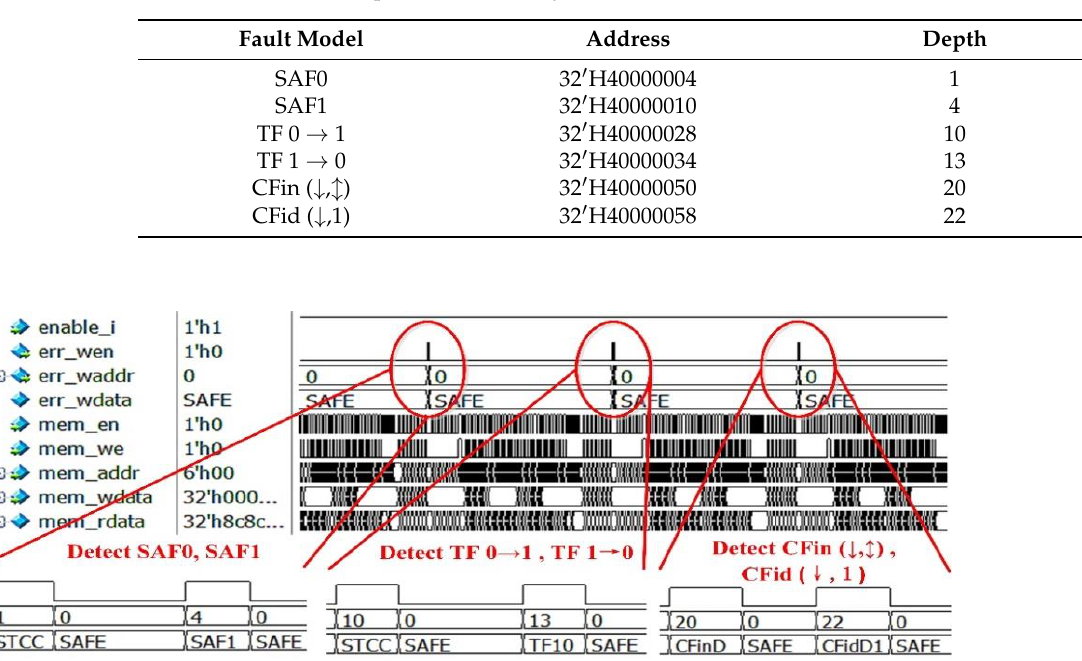
Table 4. Fault model implanted in memory.